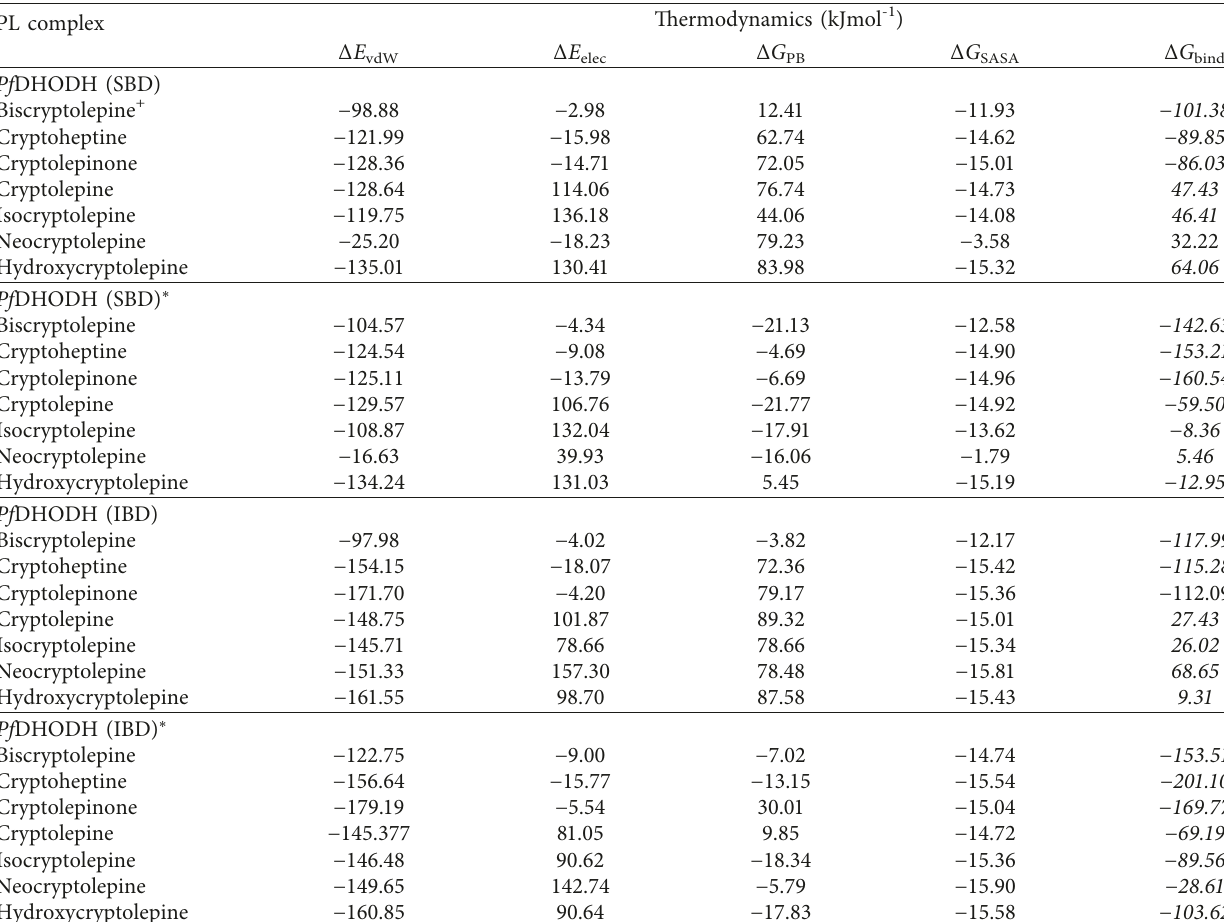
Table 7: Thermodynamics of binding of selected C. sanguinolenta alkaloid- Pf DHODH complexes formed from docked poses obtained at both teriflunomide and FMN binding sites for the entire 50ns simulation as well as the last